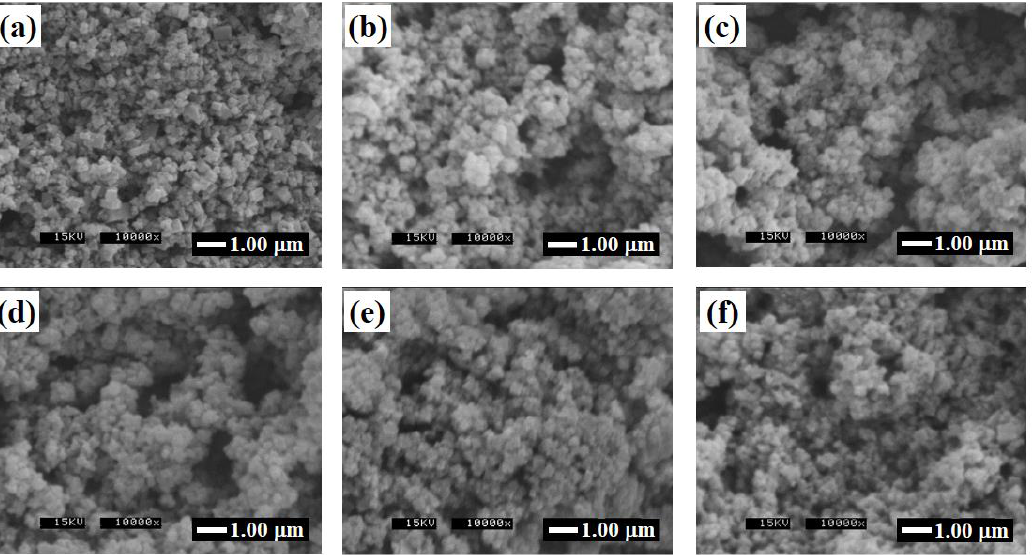
Figure 12. FE-SEM photographs of KNN particles synthesized in glycothermal conditions with various molar ratios of K + /Na + at 200 °C for 12 h: ( a ) 1.0/1.0, ( b ) 1.4/0.6, ( c ) 1.5/0.5, ( d ) 1.6/0.4, ( e ) 1.7/0.3, and ( f ) 1.8/0.2.